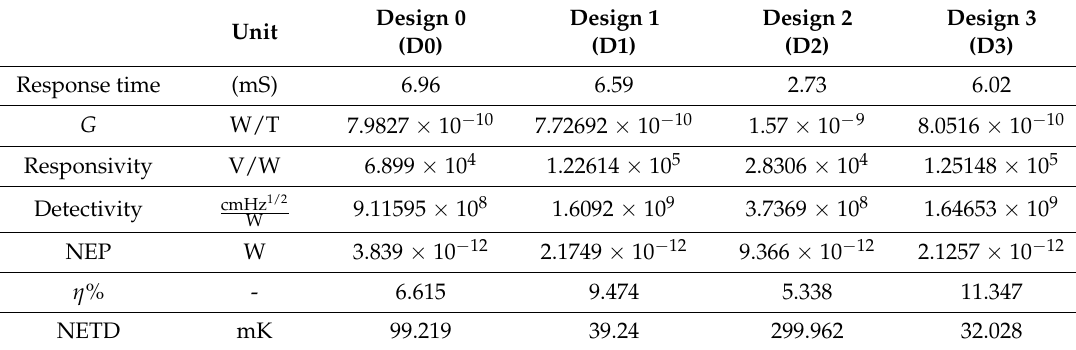
Table 3. Optoelectronic performance parameters of Design 0 to